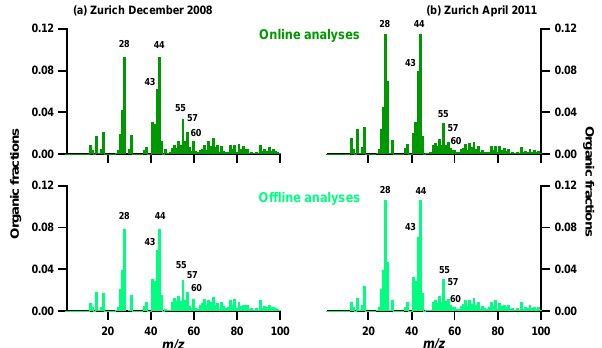
Figure 4. Comparison between 24h average online and offline AMS (both PM 2 . 5 ) spectra for winter (a) and spring (b) sam- ples, collected in Zurich. Fragments ( m/z ) commonly considered as source-specific markers are explicitly labeled with their nominal